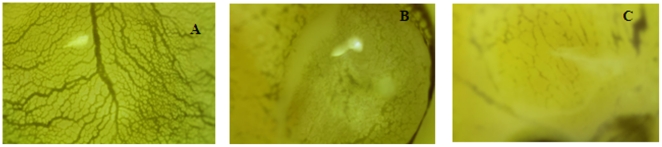
Effects of compound 1 and 2 (at 20 µg/ml) on the growth of blood capillaries on the chorioallantoic membrane of quail eggs.(A) DMSO (Control): growth of blood capillaries on the CAM – no antiangiogenic effect; (B): compound 1 (65.8% inhibition); (C): compound 2 (59.6% inhibition). Quantitative analysis was performed using a software routine which was written in the Image J-macro language, and the total small vessels number was then determined by the system as 44644 (control), 15273 (compound 1) and 18050 (compound 2). The inhibition percentage was then calculated as previously described [27].